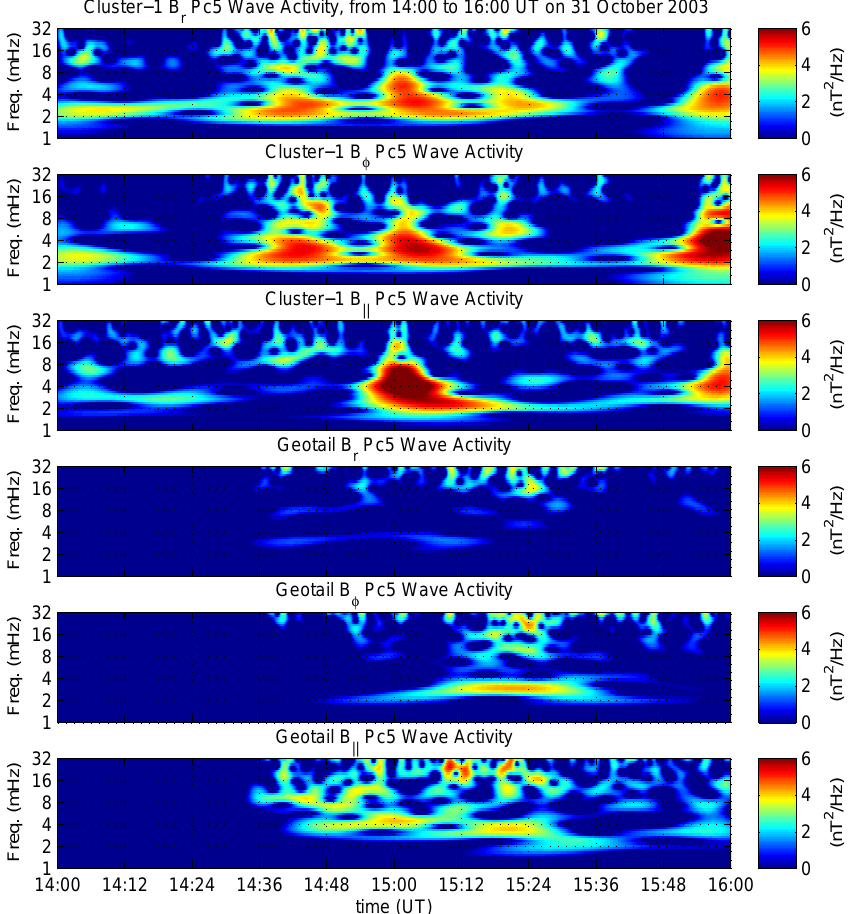
Fig. 12. Event 2: 14:00–16:00UT, 31 October 2003. From top to bottom are shown the wavelet power spectra of the Pc5 ULF wave activity from Cluster-1 poloidal, toroidal and compressional components as well as Geotail MFA